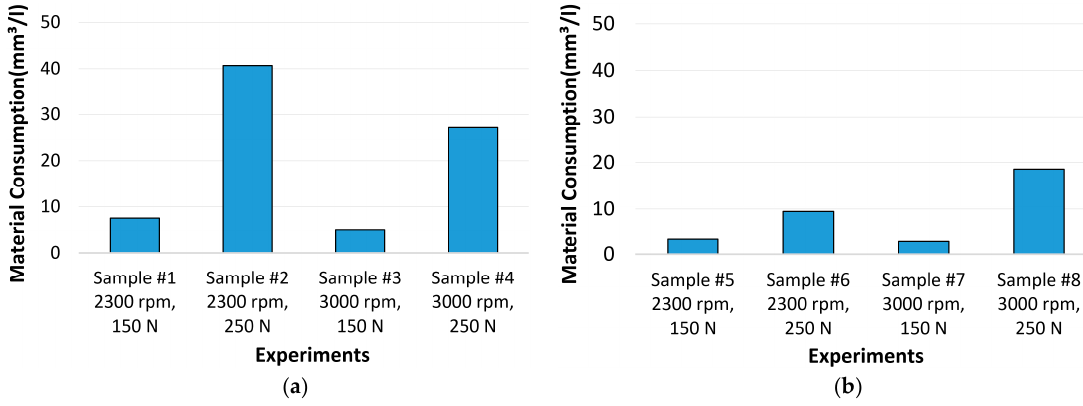
Figure 11. Tool material consumption through single- and dual-pass deposition processes: ( a ) single- pass coating; ( b ) dual-pass coating.